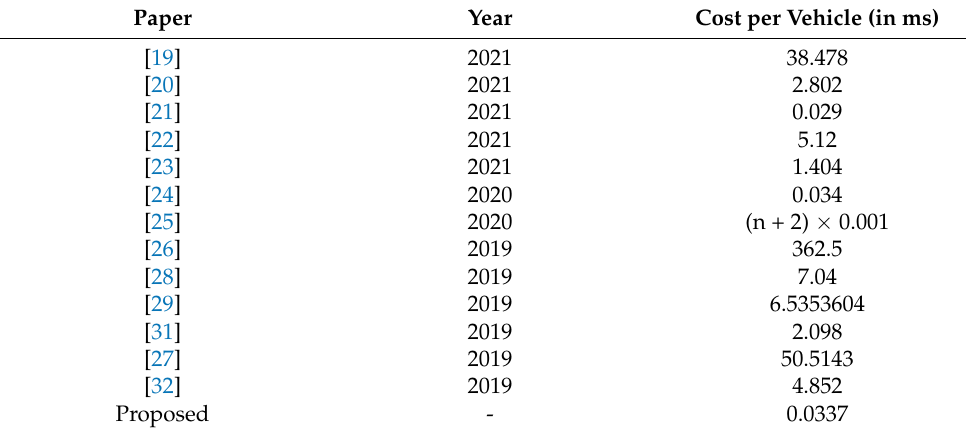
Figure 13. Computation Overhead Relative Comparison. Table 8. Comparison of Computational Overhead.